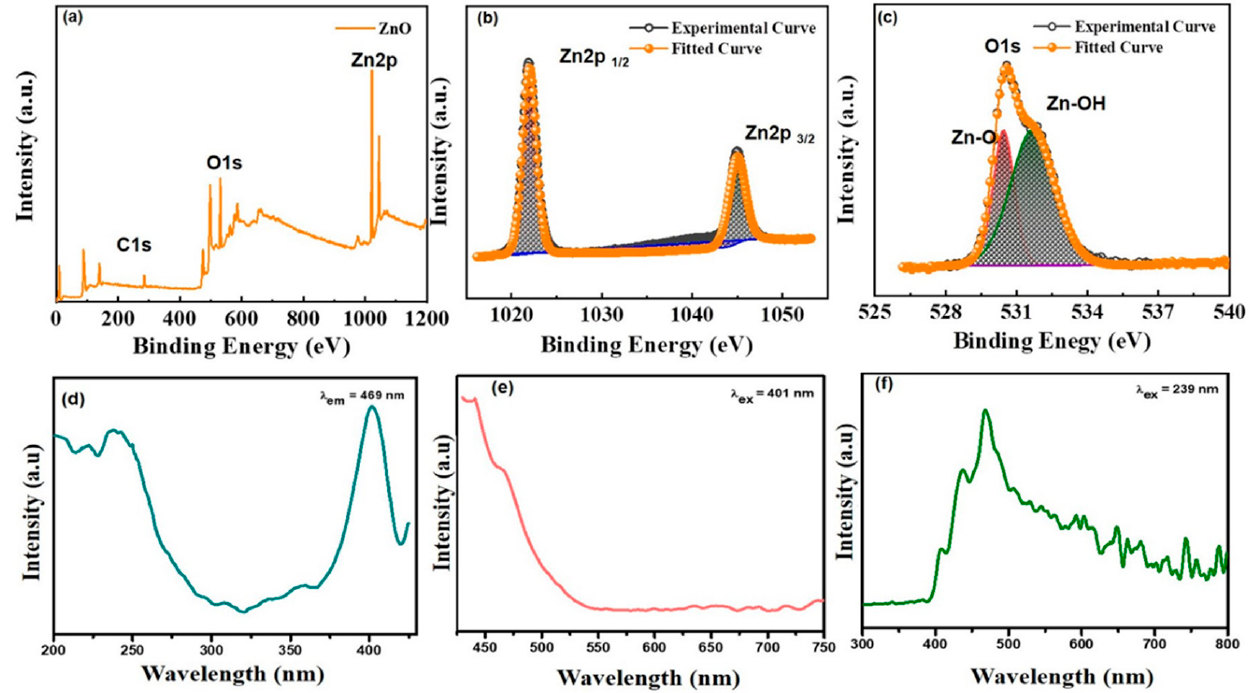
Figure 3. X-ray photoelectron spectroscopy (XPS) and PL analysis of LC-ZnO/OF. Full survey spectrum ( a ); Zn2p binding energy region ( b ); O1s binding area ( c ). Emission wavelength spectra ( d ) and Excitation wavelength ( e , f ).